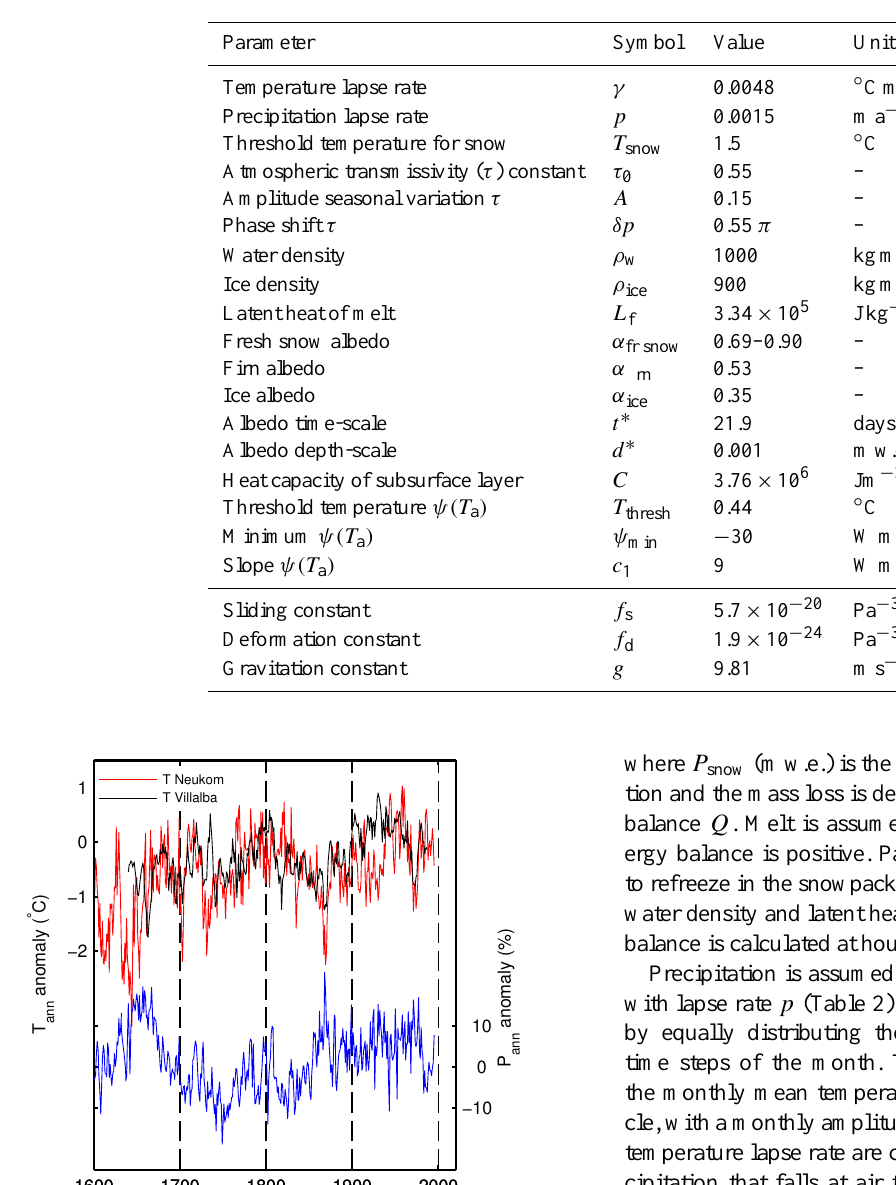
Table 2. Model parameter values of the surface mass balance model and the ice-dynamical model.